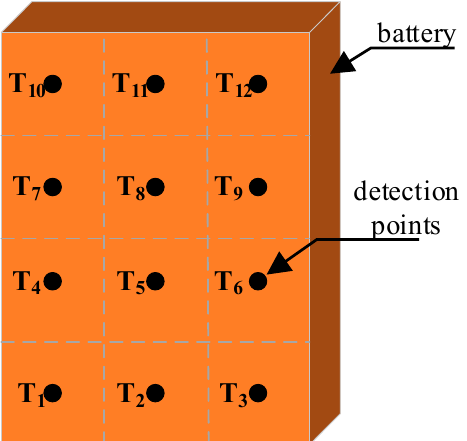
Figure 3. The distribution of the temperature detection points (T 1 , T 2 , … T 12 ) on the ba tt ery surface.